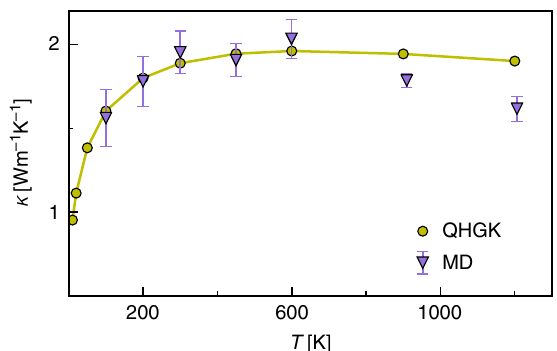
Fig. 2 Quantum thermal conductivity. Thermal conductivity computed for a 13824-atom supercell of a-Si using the quantum QHGK approach in the quantum regime (Eq. (9)), compared with the Allen-Feldman approach 9,10,23 and experimental data (yellow triangles and orange diamonds ref. 27 ), (green triangles ref. 28 ). The broadening η used in Allen- Feldman calculations is set equal for every normal atoms along with three sets of experimental data 27,28 . QHGK